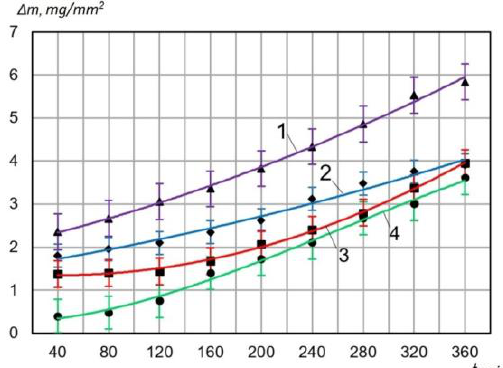
Fig. 7. Wear kinetics of samples from 40ХН2МА steel in the initial state and after ionic nitriding. 1 – virgin sample; 2 – nitrided sample №3; 3 – nitrided sample №2; 4 – nitrided sample